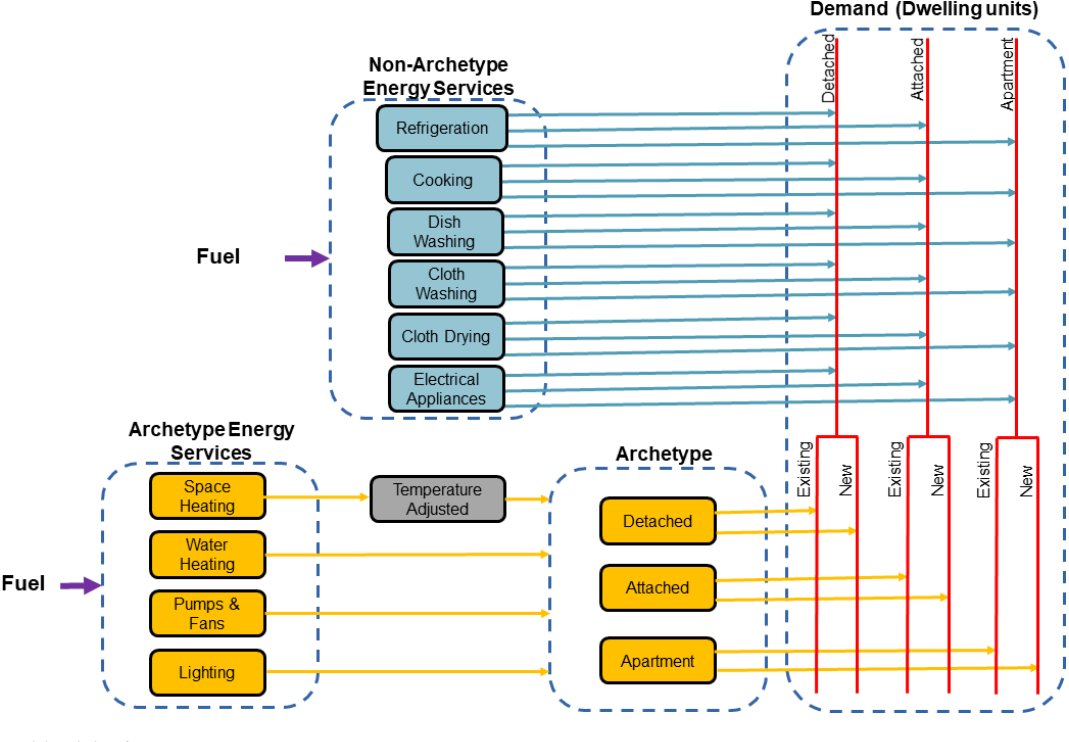
Figure 5. Residential reference energy system.